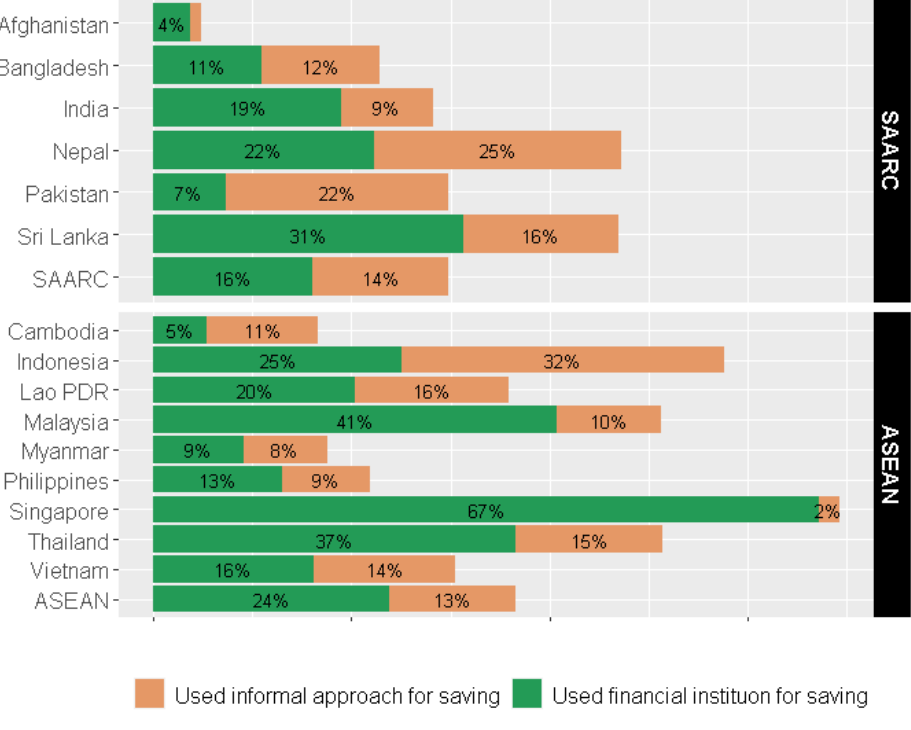
Figure 5. Cumulative percentage of participants who saved money in a bank or a financial institution, and who used informal approaches, such as a group, or a club, or a person beyond the family.